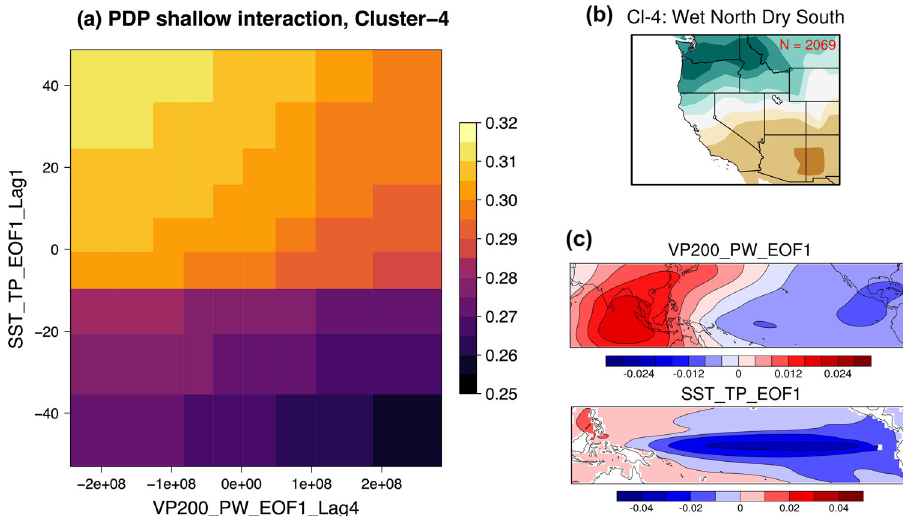
Fig. 7 Partial dependence plot for the shallowest pairwise variable interaction. Panel a indicates that strongly negative values of VP200_PW_EOF1_Lag4 (i.e., the August value of the fi rst EOF of VP200) combined with a strongly positive SST_TP_EOF1_Lag1 (i.e., the November value of the fi rst EOF of tropical Paci fi c SST) increases the probability (shaded colors) of a JFM Cluster-4 (panel b ) precipitation anomaly occurrence. This relates to La Niña like conditions in November and enhanced convection conditions in the Indian Ocean/Maritime continent in August (panel c ). Partial dependence plots for other variable interactions are shown in Supplementary Material Figs. S13 and